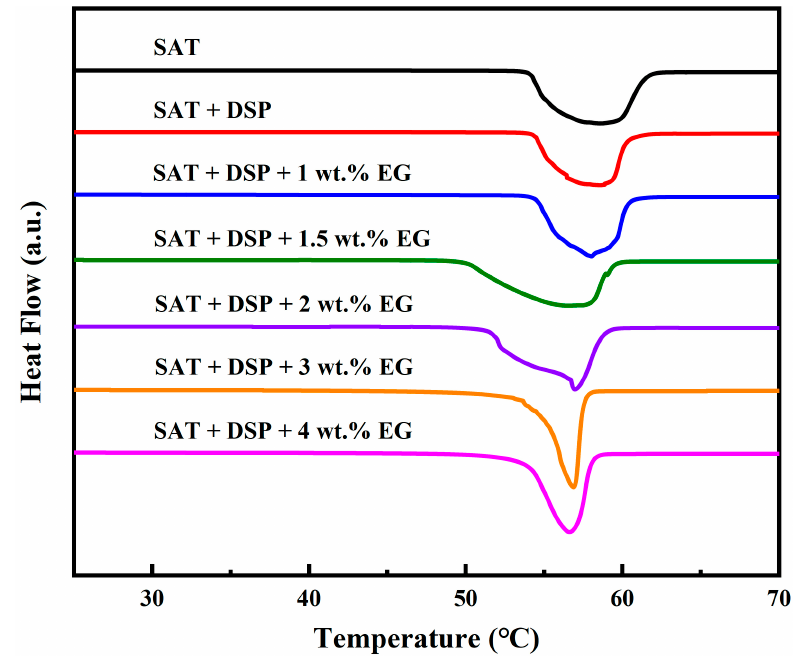
Figure 9. DSC chart of SAT and CPCM.